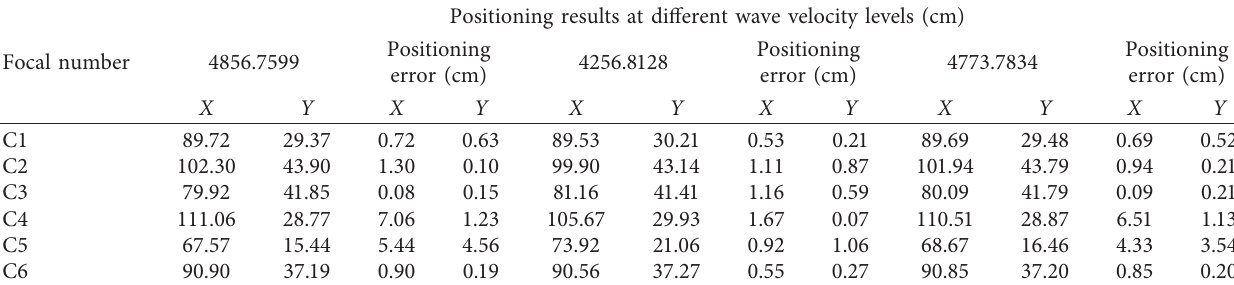
Table 16: Source location results for Scheme II of GAM-L.